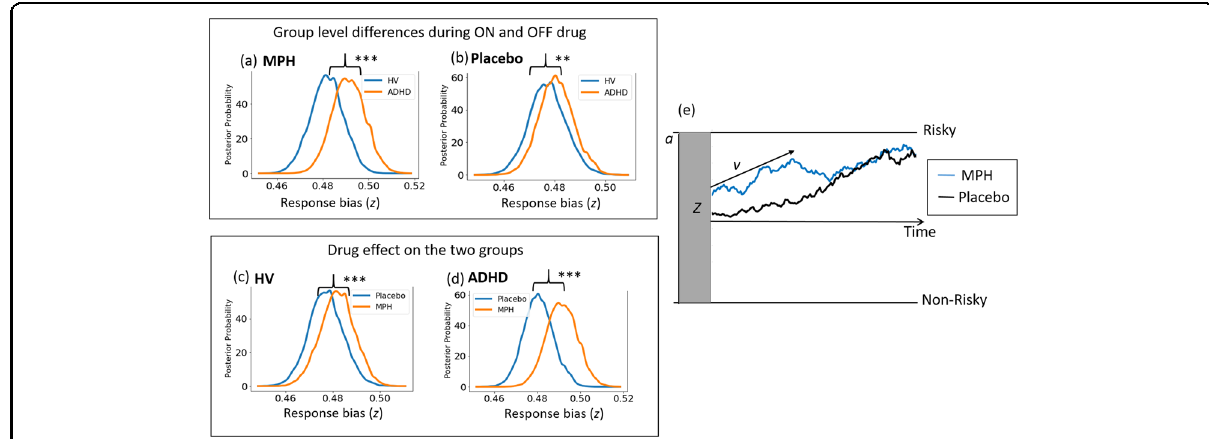
Fig. 2 Effect of methylphenidate (MPH) on the starting or response bias in control and patient groups. ( a , b ) Comparison of response bias ( z ) in healthy volunteers (HV) and attention-de fi cit hyperactivity disorder (ADHD) on (MPH) and placebo ( c ) Comparison of response bias ( z ) of HV on MPH or placebo and ( d ) Comparison of response bias ( z ) of ADHD on MPH or placebo and ( e ) Pictorial representation of evidence accumulation process and the effect of